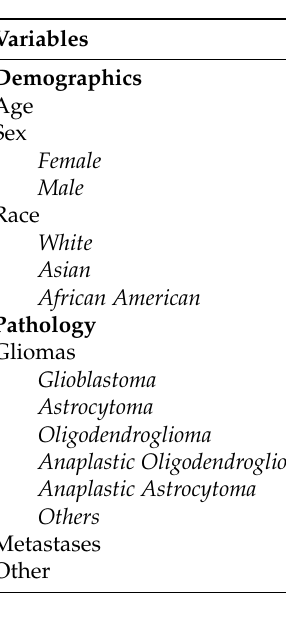
Table 2. Distribution of tumor laterality, anatomical compartments, and intraoperative opening